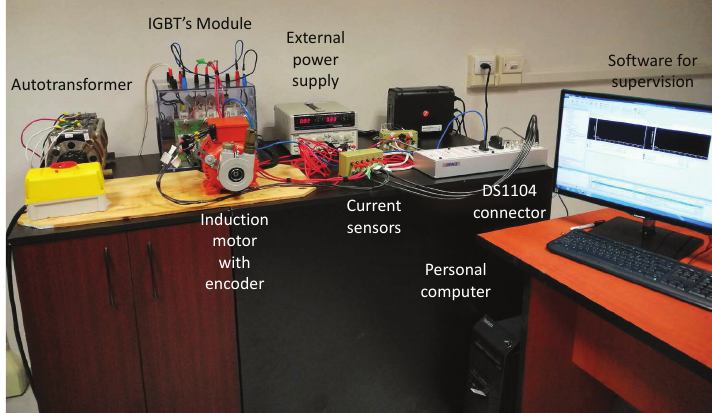
Figure 2. Rotatory induction motor test bench for sensor fault classification. FDI model-based schemas use observers to monitor the sensors in cases of